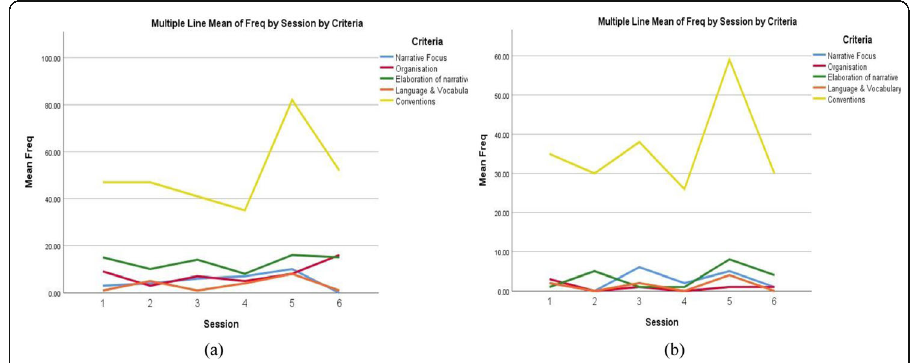
Fig. 3 TA ( a ) and PA ( b ) patterns of distribution on narrative